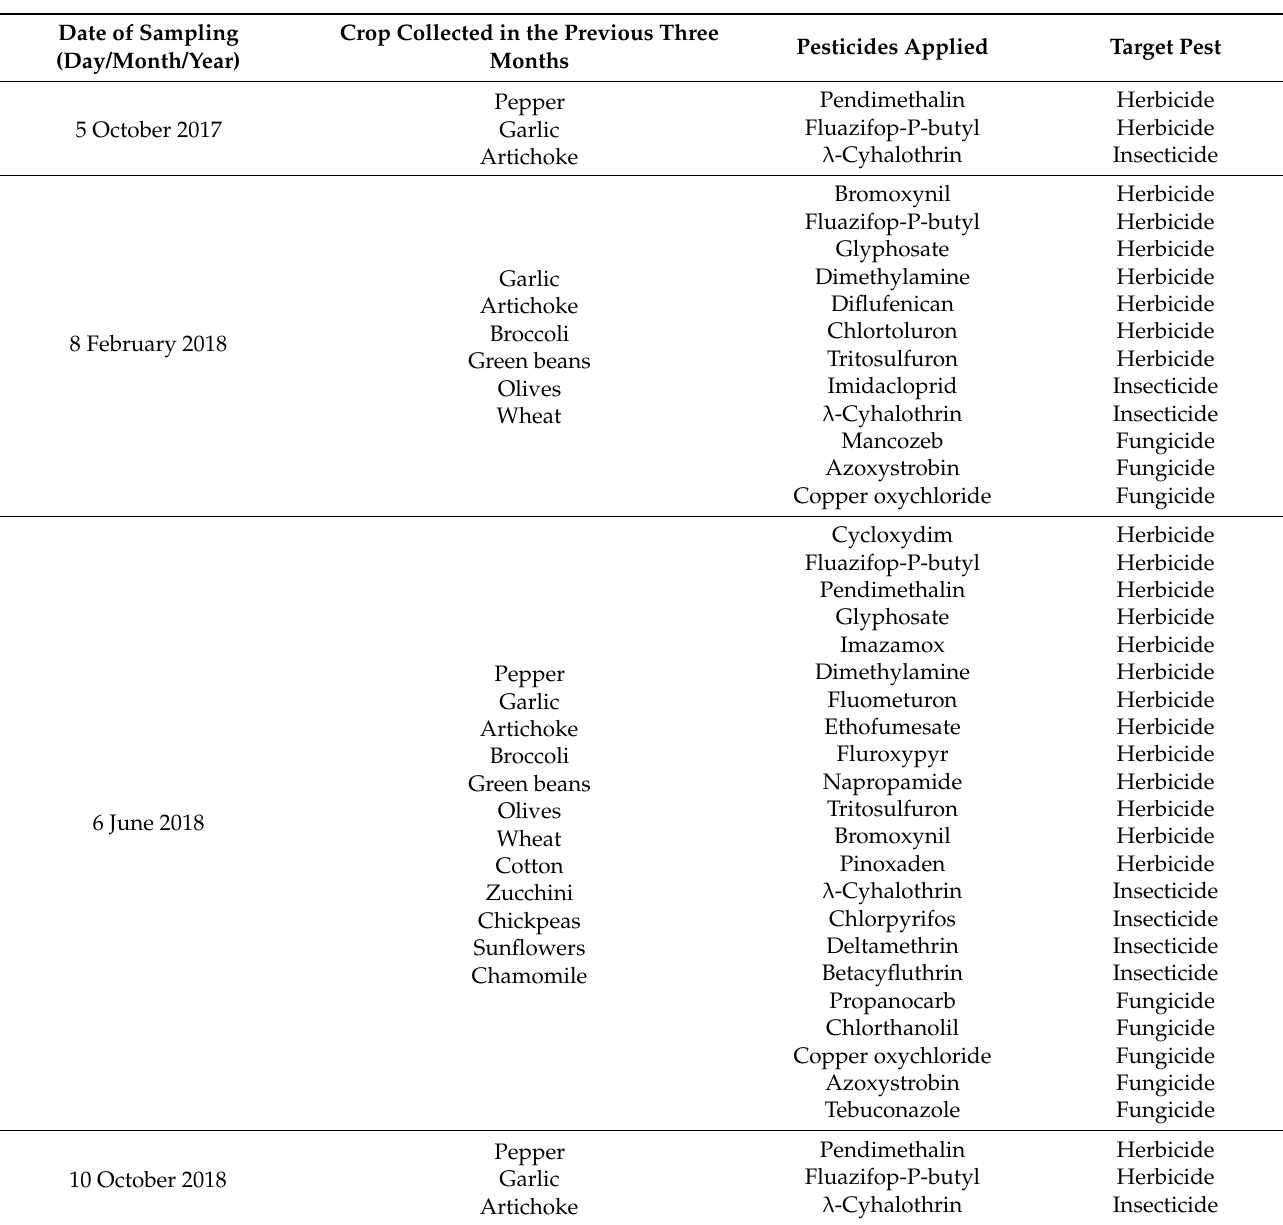
Table 1. Chronogram of sampling, crops collected and the pesticides most used along the whole